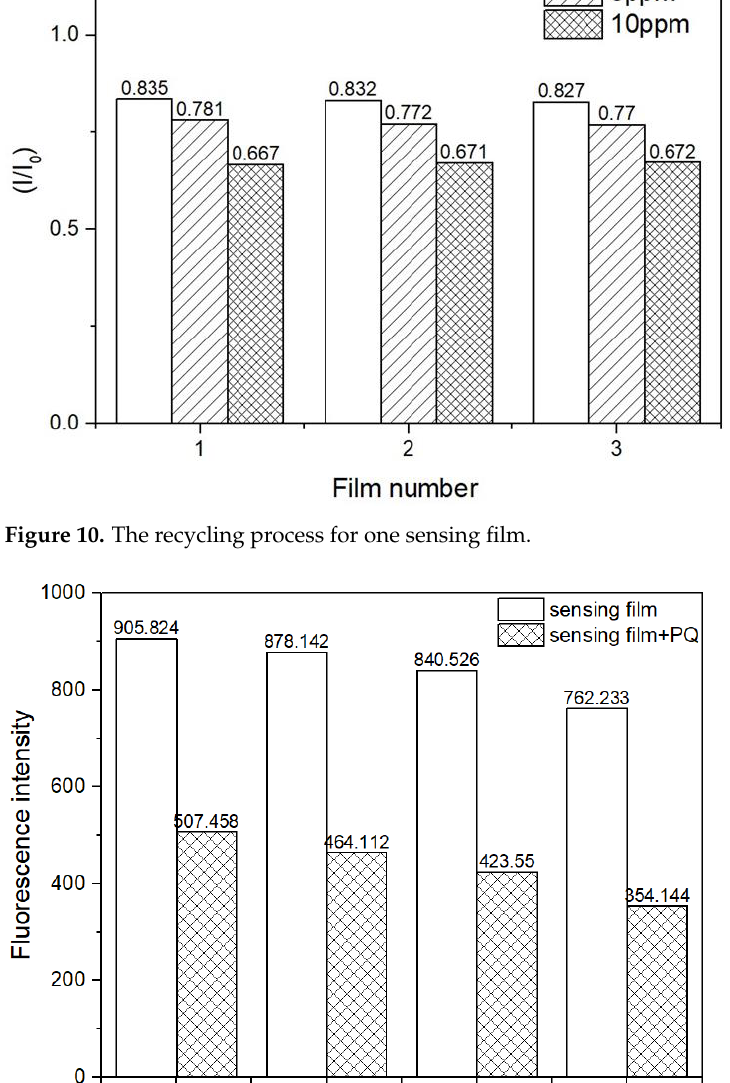
Table 1. Effect of foreign species. Tested Species